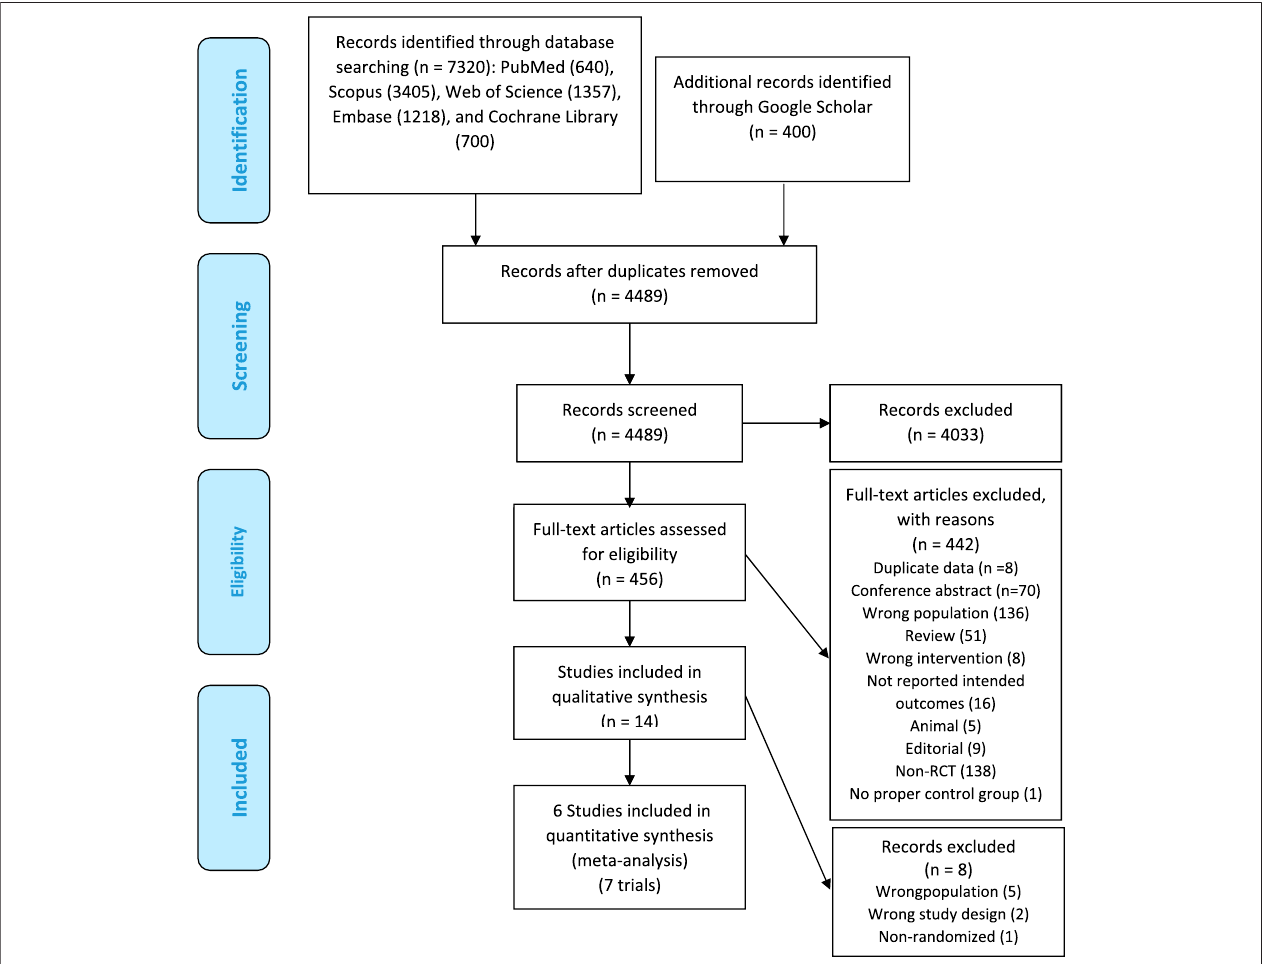
FIGURE 2 | Flowchart of the identi fi cation studies and selection